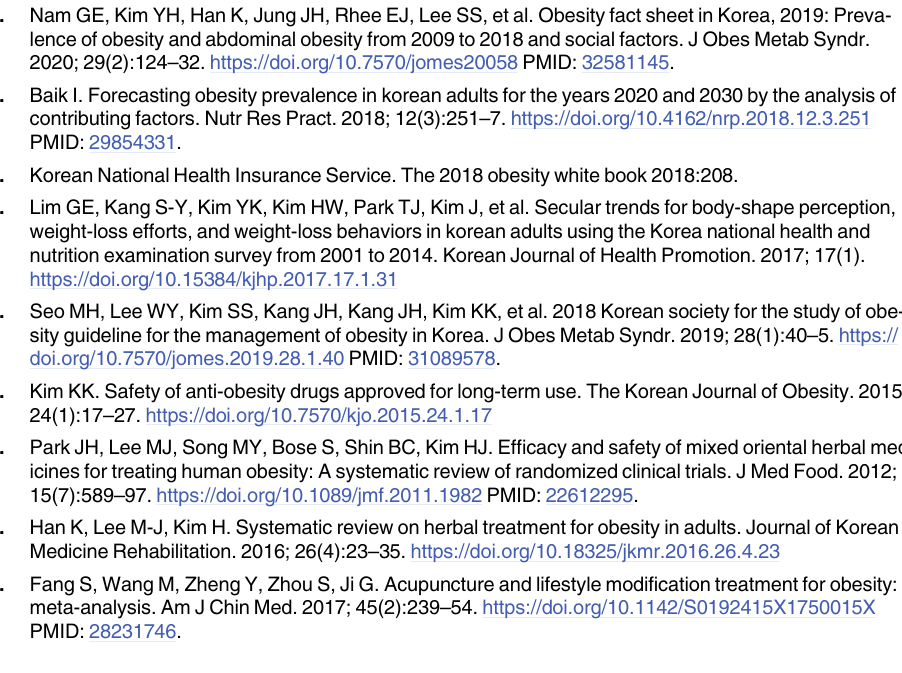
S1 Table. Patient satisfaction with treatment for obesity. S2 Table. Difficulties in obesity